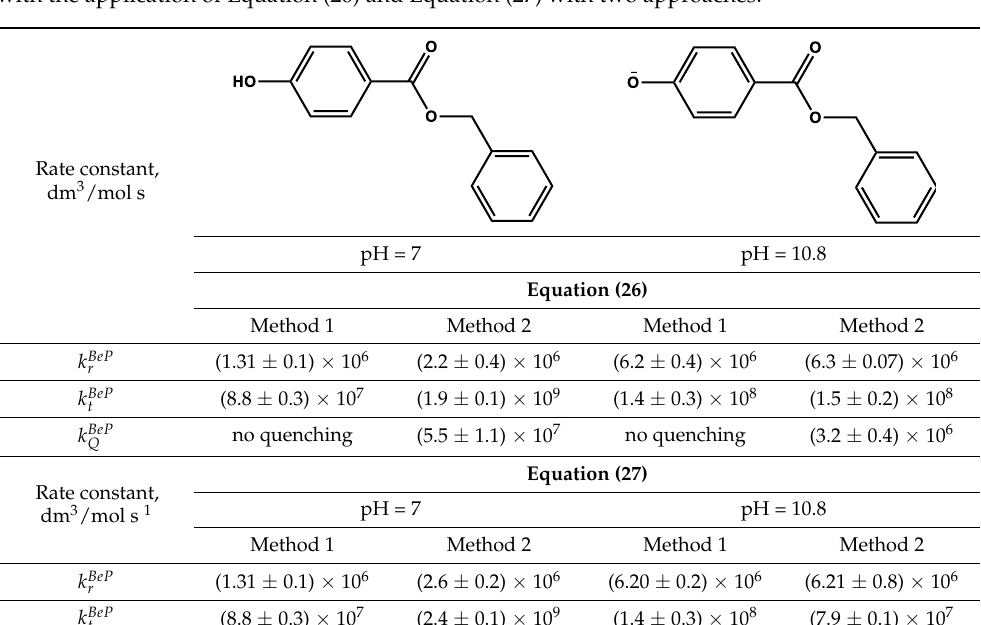
Table 5. Determined kinetic rate constant of 2CP reaction with singlet oxygen and excited 3 TPPS 4 * with the application of Equation (26) with two approaches .